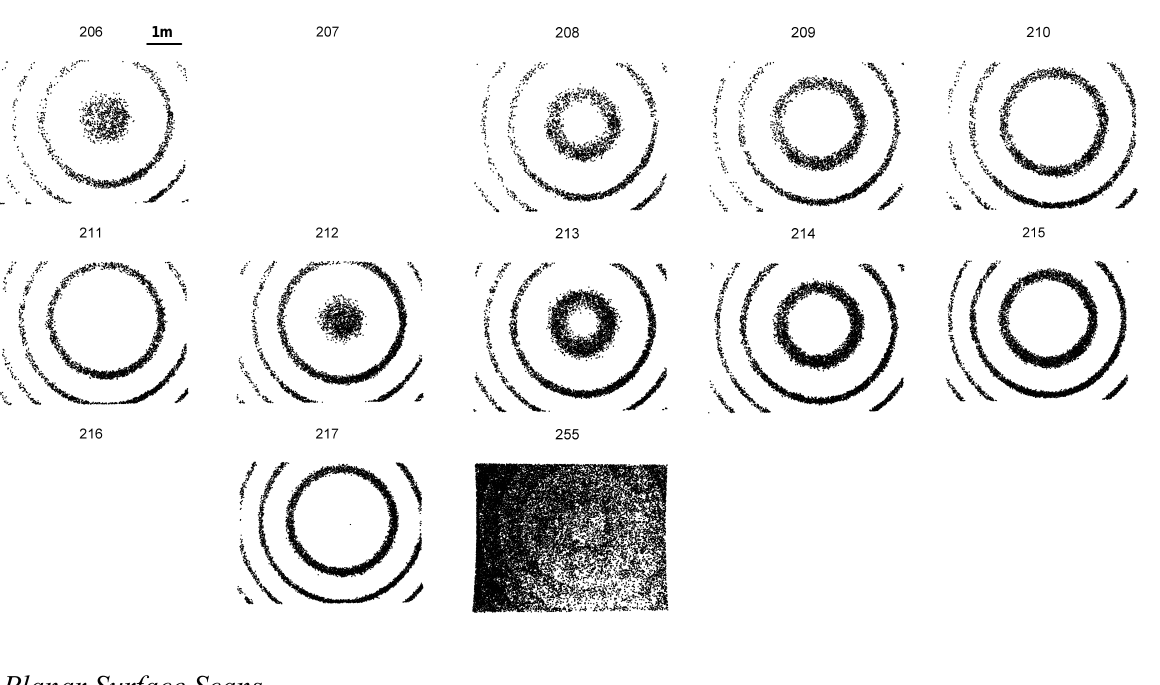
Figure 3. Grey intensity images of 206 to 217 and 255 excerpted from the grey intensity image sequence of a homogeneous white wall [red rectangle in Figure 1(a)] in Supplementary Material 1, which contains the complete grey intensity of